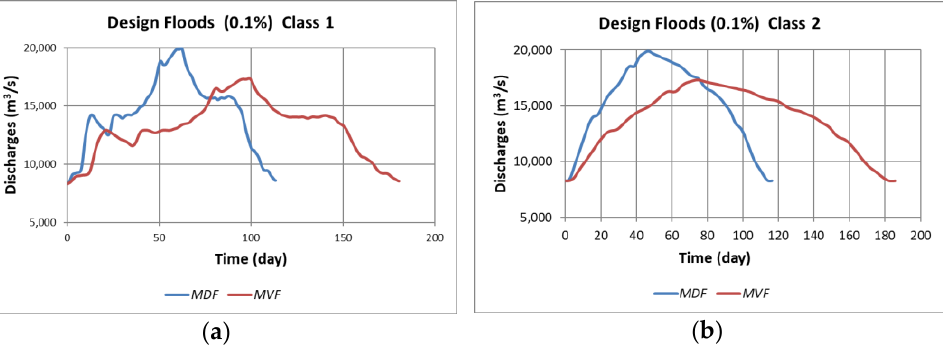
Figure 12. MDF and MVF : ( a ) Class 1; ( b ) Class 2 (Turnu- Măgurele gauge station) .